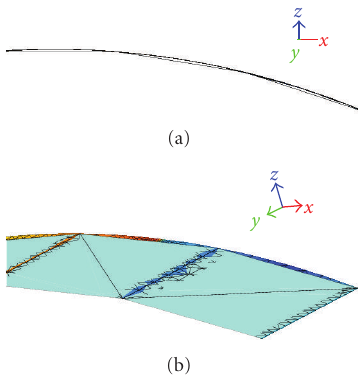
Figure 18: Details of the di ff erences between original and adapted projected grid for the channel bump—(a) view from the side, (b) tilted view from underneath the bump.